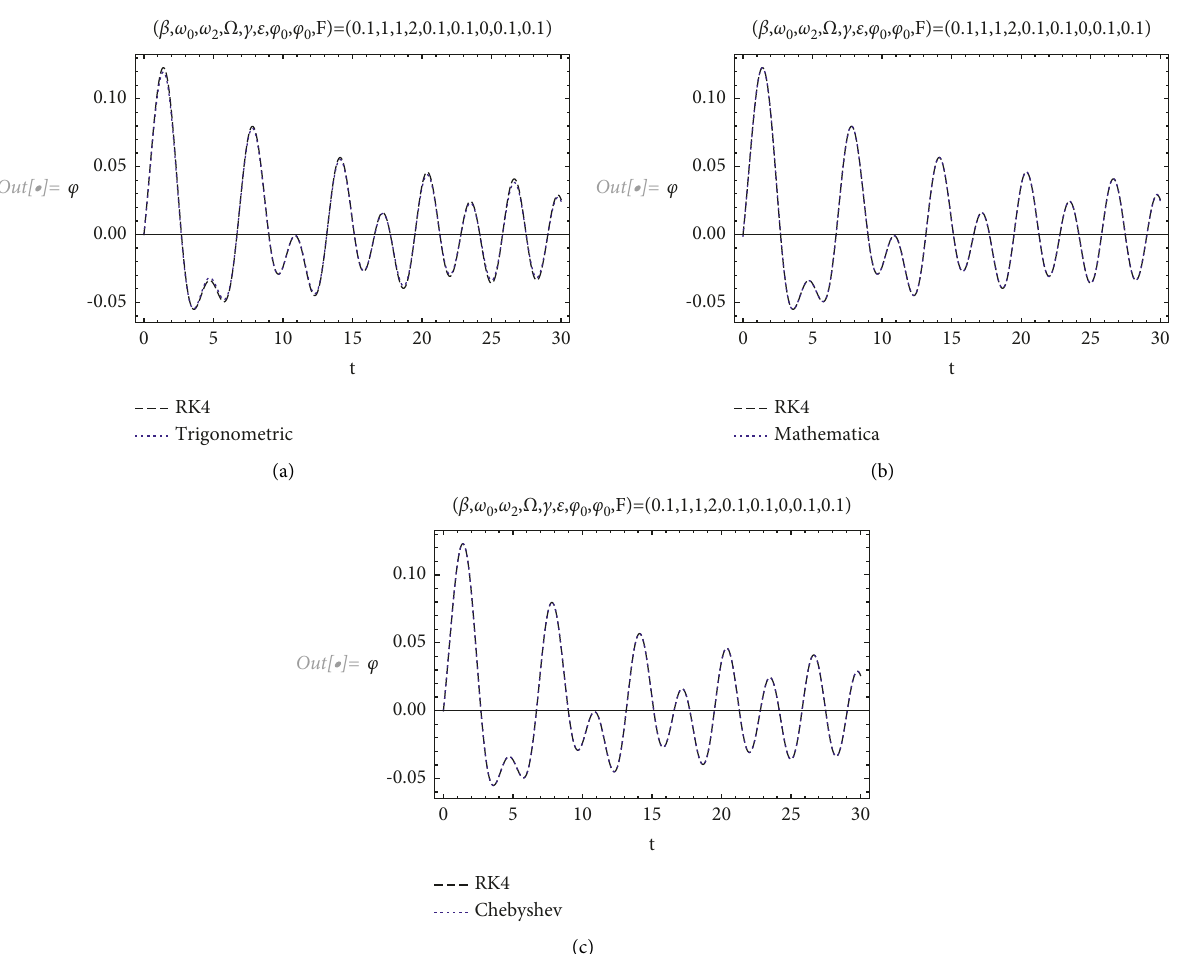
β , ω 2 , F 0 . 1 , 1 , 0 . ( ) (cid:28) ( )